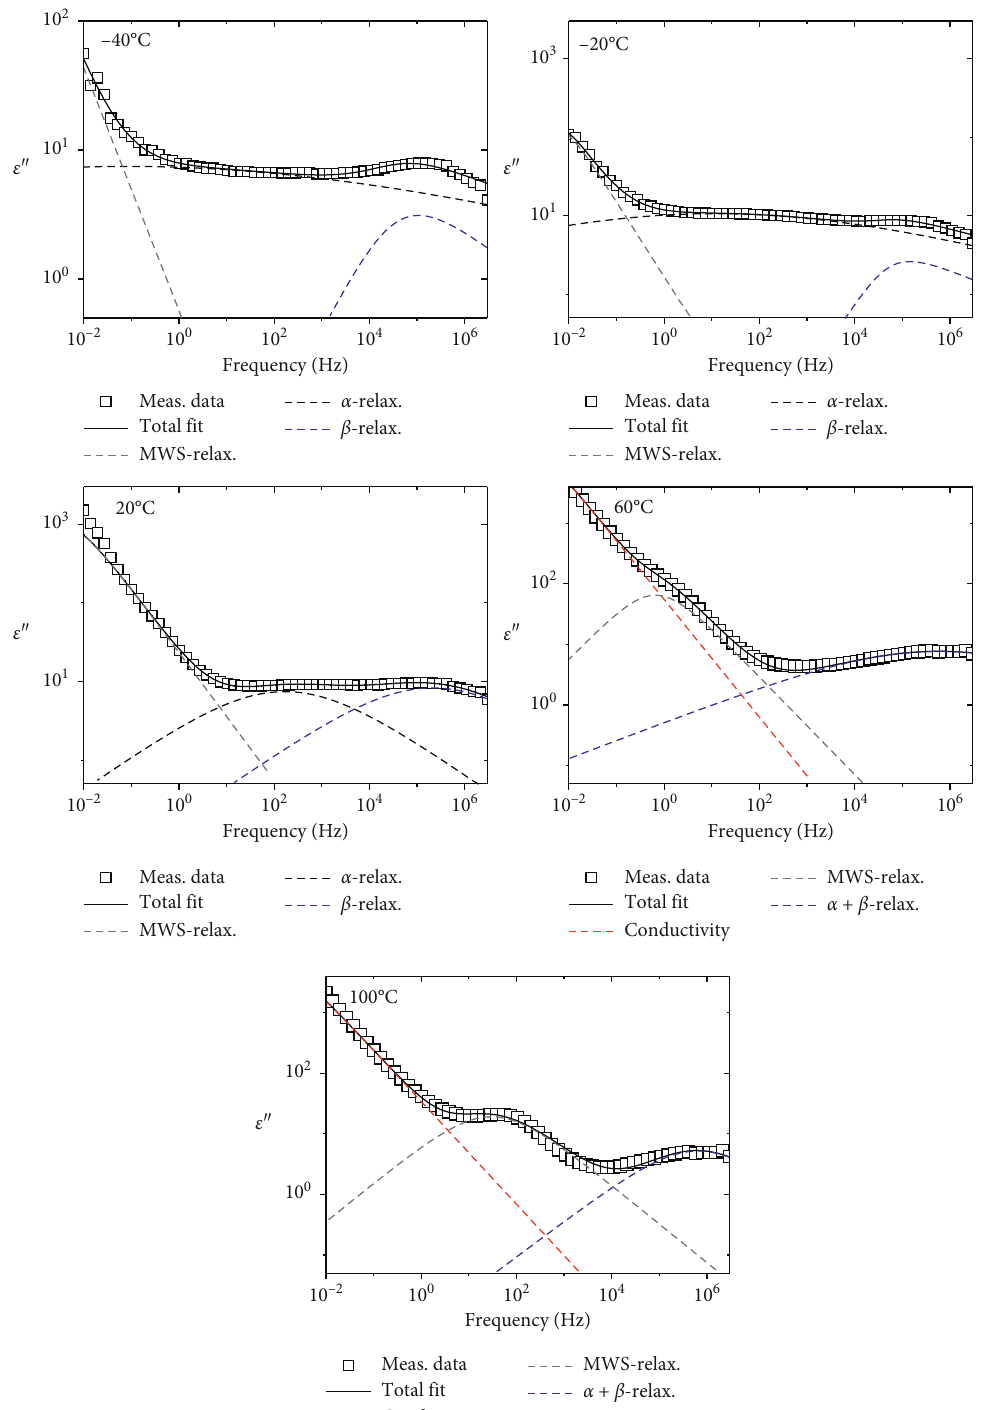
Figure 12: Simulation results for five representative temperatures in the range from − 40 ° C to 100 ° C. The total fitting results are presented with black solid lines through the data (open square), which are the sum of the black dashed line ( α -relaxation), blue dashed line ( β -relaxation), gray dashed line (MWS relaxation), red dashed line (conductivity), and navy dashed line ( α + β